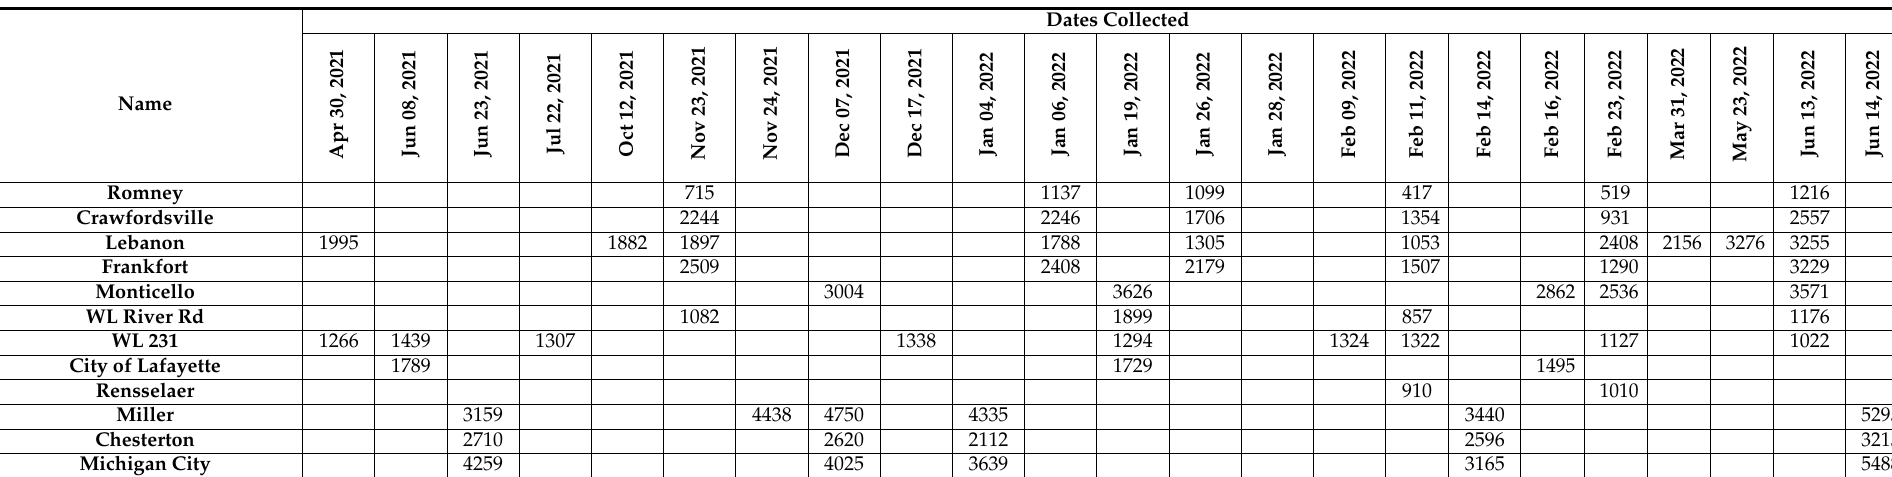
Table 2. Salt pile inventory in cubic yards over the 2021–2022 winter